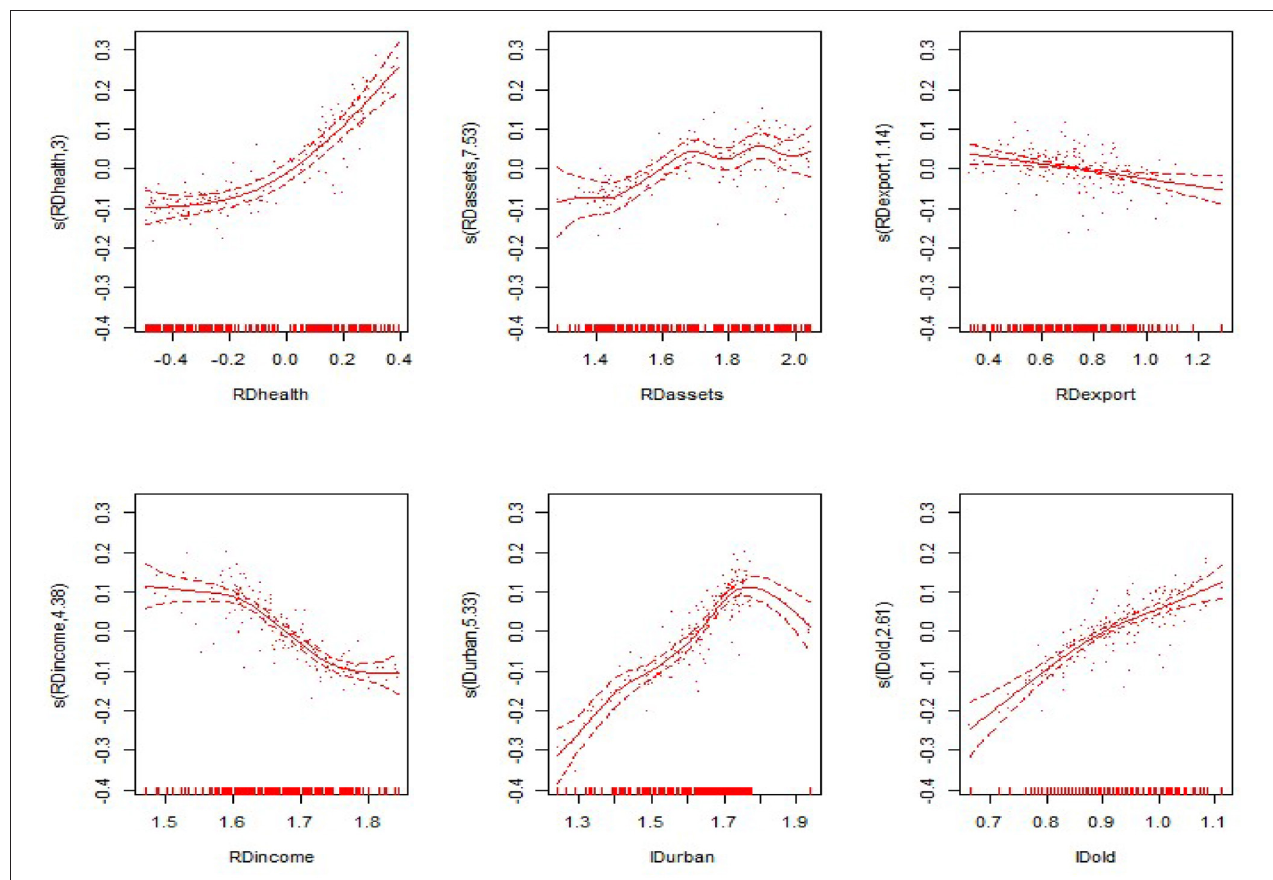
FIGURE 9 | Comprehensive effects of the explanatory variables on per capita GDP in the central